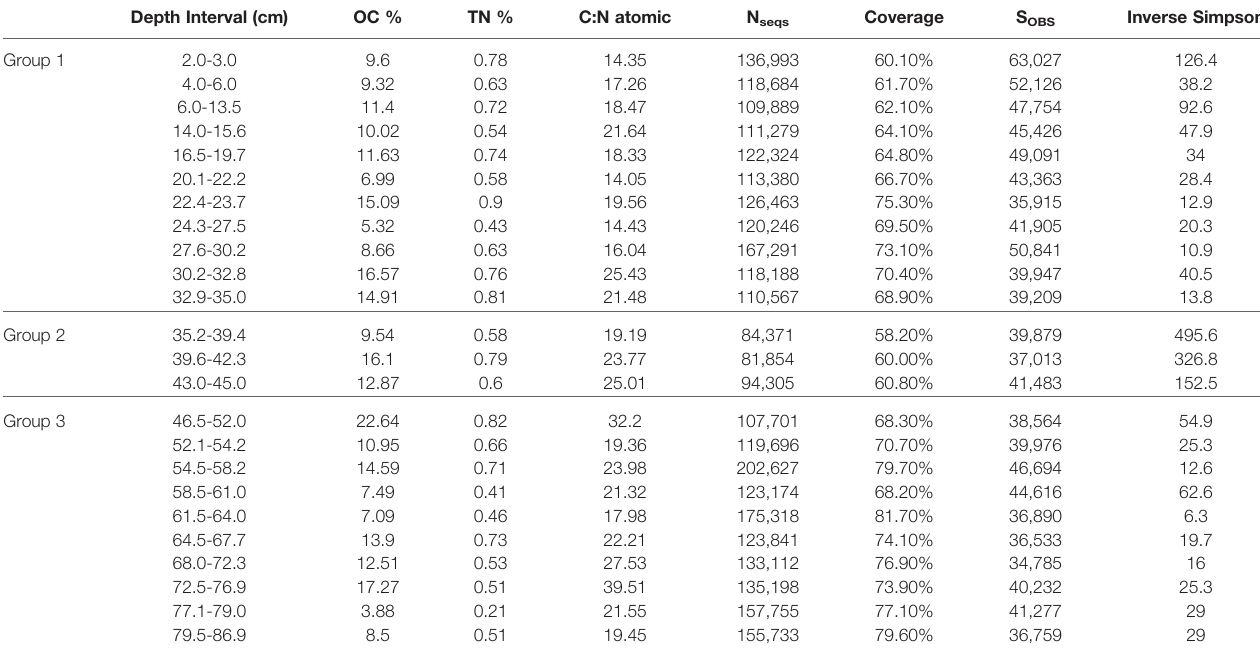
TABLE 1 | Downcore organic matter analysis [OC% (organic carbon corrected to the initial volume of sediment), TN% (total nitrogen) and C:N atomic ratios] as well as sequence-based calculations [Number of sequences (N seq ), sequence coverage, observed richness (S OBS ), and inverse Simpson index] for core BLWD C7. Depth Interval (cm) OC % TN % C:N atomic N